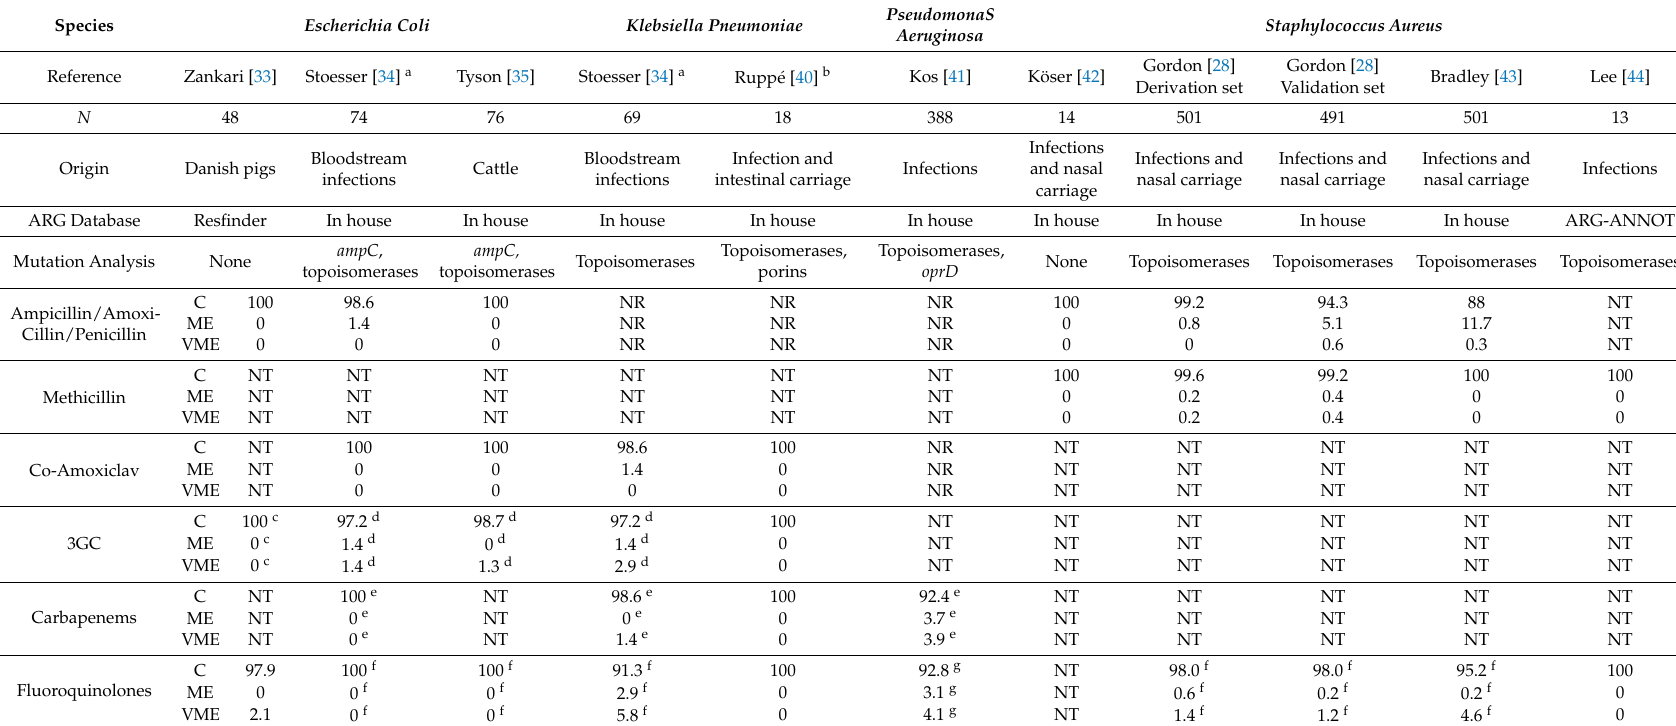
Table 1. Summary of the performances of the genotype-to-phenotype studies performed on Escherichia coli , Klebsiella pneumoniae , Pseudomonas aeruginosa and Staphylococcus aureus . N: number of tested strains. 3GC: third-generation cephalosporins. C: correct, (WGS agrees with conventional methods). ME: major errors (WGS predicts resistance while the strain tested susceptible). VME: very major errors (WGS predicts susceptibility while the strain tested resistant). NT: not tested. NR: not